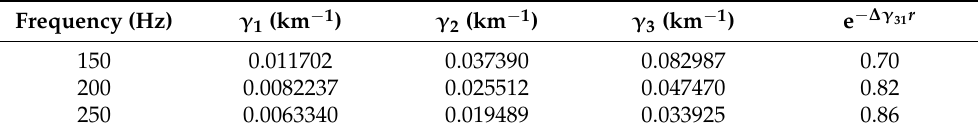
Table 5. Recalculated results of quantities listed in Table 4 obtained by neglecting shear wave speed c 3, s and without changing the other geoacoustic parameters (source receiver distance r = 5.35 km). Frequency (Hz) γ 1 (km − 1 ) γ 2 (km − 1 ) γ 3 (km − 1